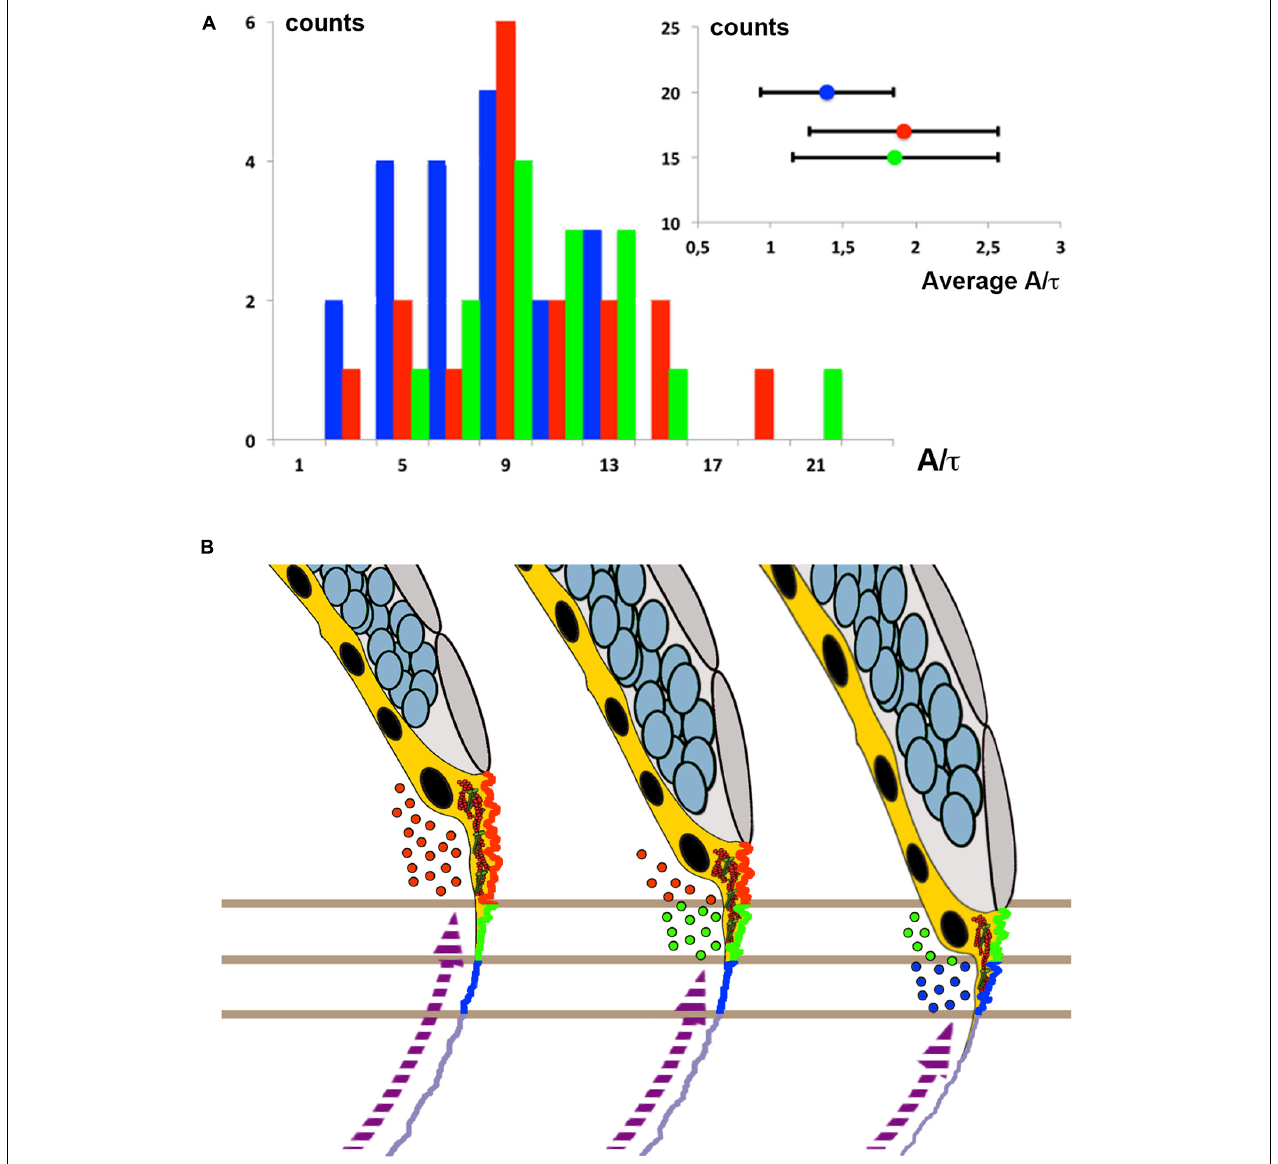
FIGURE 5 | Membrane cortical tension and endocytosis at the E-YSL are necessary for epiboly progression. (A) The distribution (counts) of instant retraction velocities (A/t) after laser surgery of the actomyosin cortex of Myosin-GFP (Tg ( β - actin:MYL12.1-eGFP ) rab5ab YMOs at 55% epiboly (blue) shows a significant reduction (Wilcoxon test p < 0.01) versus wild type (red) and control YMOs (green). The instant velocity estimate was extracted from the exponential fit of the distance between fronts (see section “MATERIALS AND METHODS”). The averaged instant retraction velocity (A/ t) for rab5ab YMOs was 1.39 ± 0.46 µ m ( n = 20), while control YMOs reach 1.86 ± 0.71 µ m ( n = 17) and wild type embryos 1.92 ± 0.65 µ m ( n = 15) (inset). Counts represent the number of analyzed laser cuts for each condition. (B) Proposed model of epiboly progression. The contractile E-YSL and the imbalance of stiffness between the EVL and the yolk cell surface account for epiboly progression. Rab5ab-mediated yolk cell localized endocytosis (color coded dots) accounts for the reduction of the yolk cell surface coupled to the progression of EVL (gray) and DCs (blue) toward the vegetal pole. Membrane removal associates to the convolution and contraction of the E-YSL surface and the recruitment of actin and myosin (purple dashed arrow) from vegetally located pools. Three chronological time points are shown. Different sequential zones on the surface of the E-YSL are color-coded. Actin and myosin are diagrammatically illustrated in red and green within the YSL